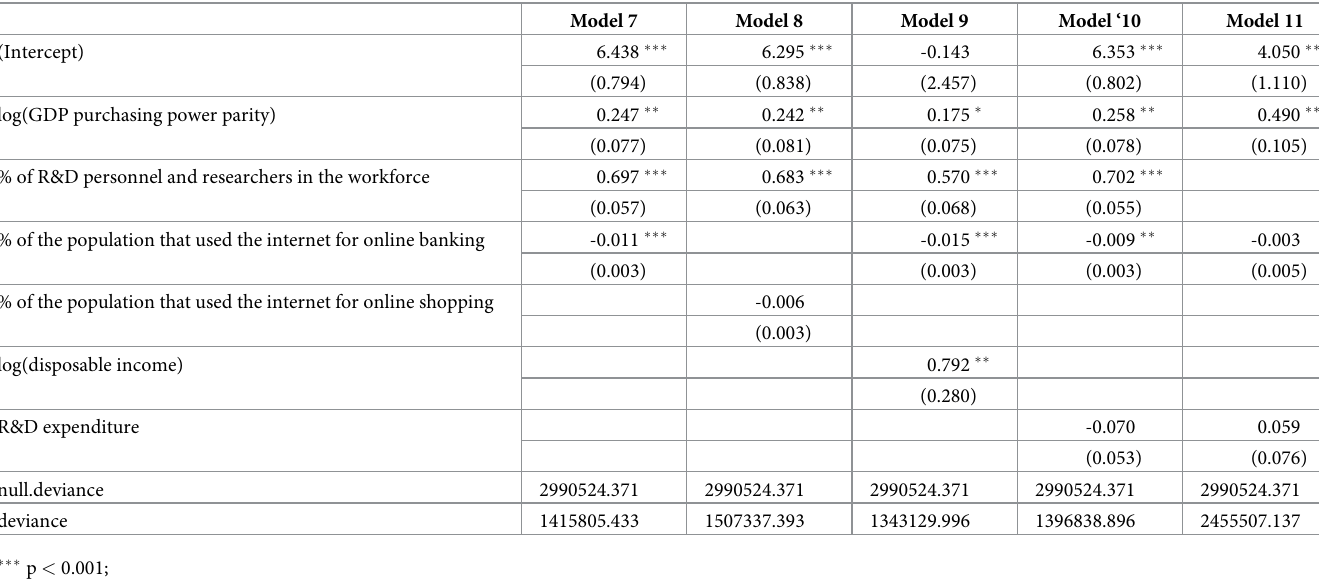
Table 7. European models I. (DV: download per